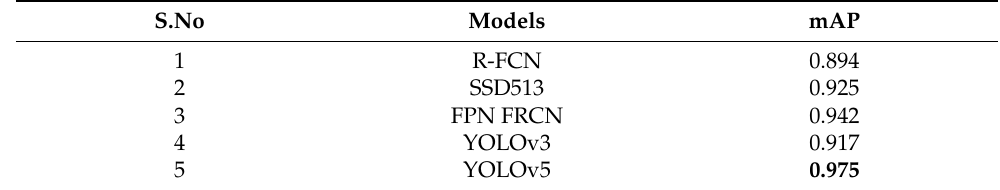
Table 5. This table represents the comparison of different models. YOLOv5 has the highest mAp value, which means it outperforms other object